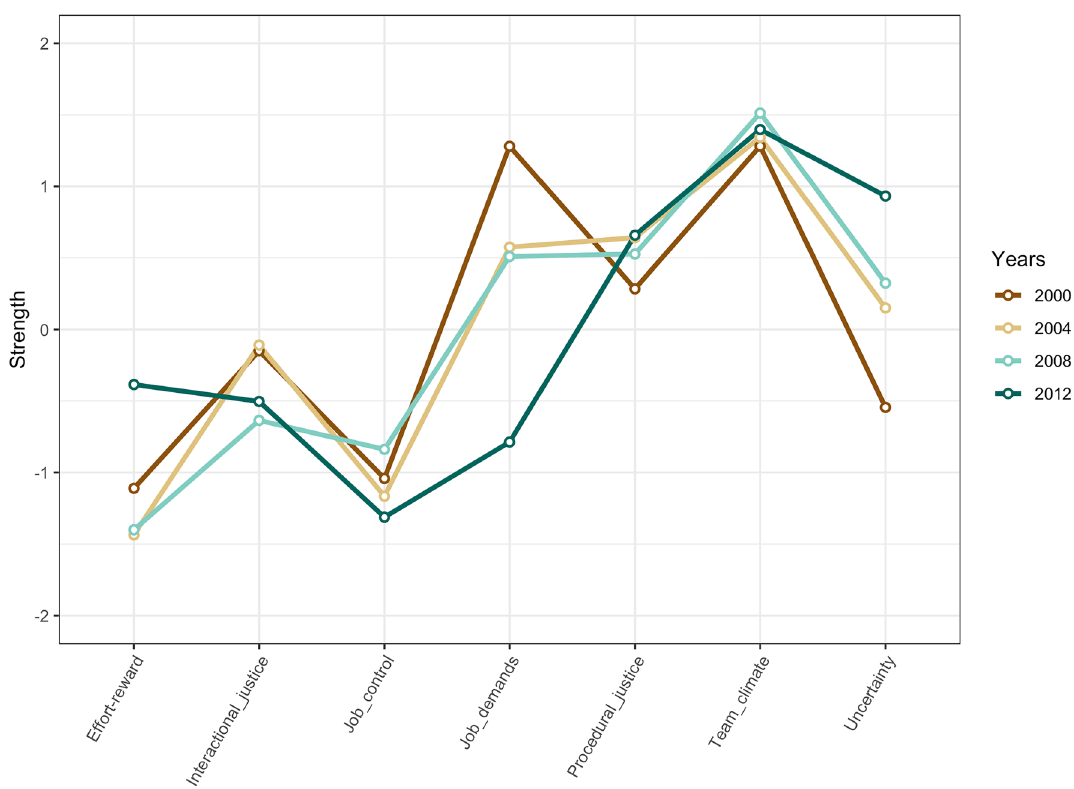
Figure 2. Strength centrality index for years 2000, 2004, 2008 and